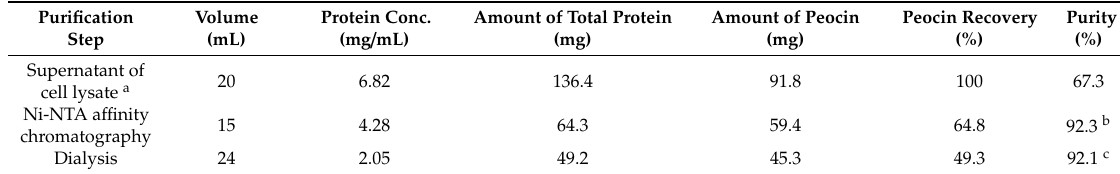
Table 1. Protein recovery in a representative